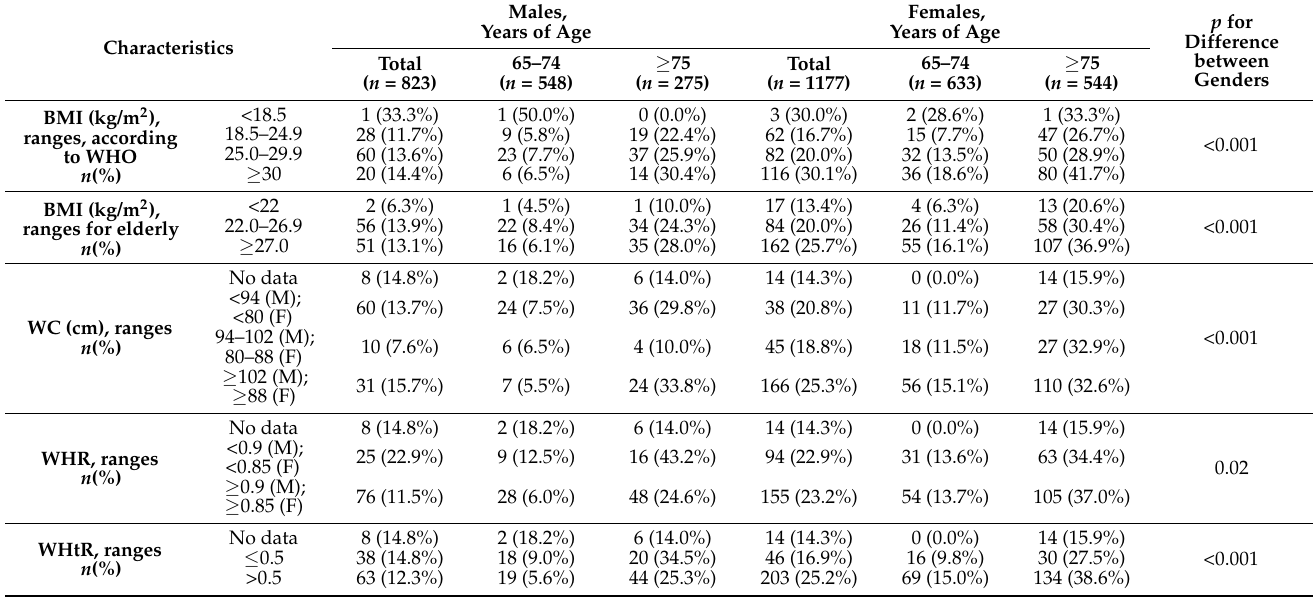
Table 3. Sarcopenia risk prevalence in adiposity groups.